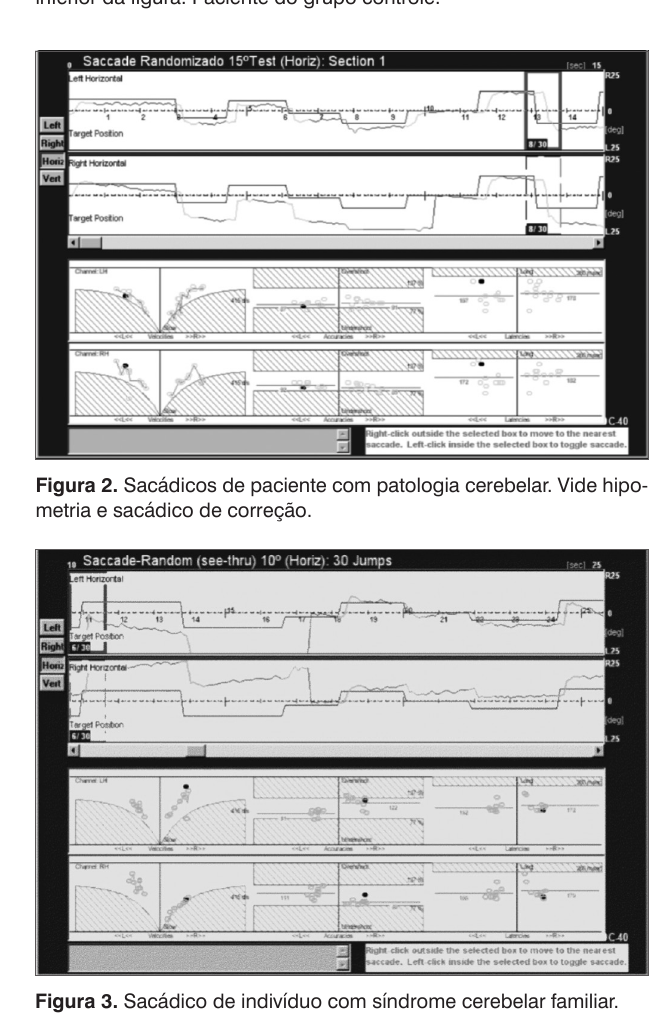
Figura 1. Registro dos traçados dos sacádicos em cada olho (direito e esquerdo) e gráficos da velocidade, latência e acurácia na parte inferior da figura. Paciente do grupo controle.